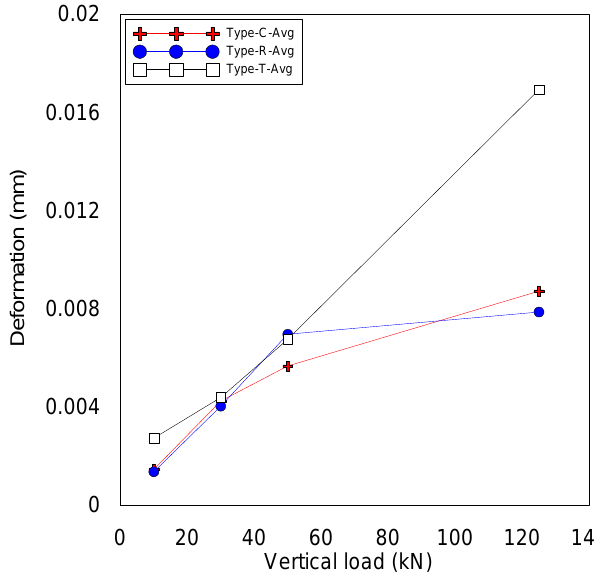
Figure 16. Averaged deformation – vertical load curves.